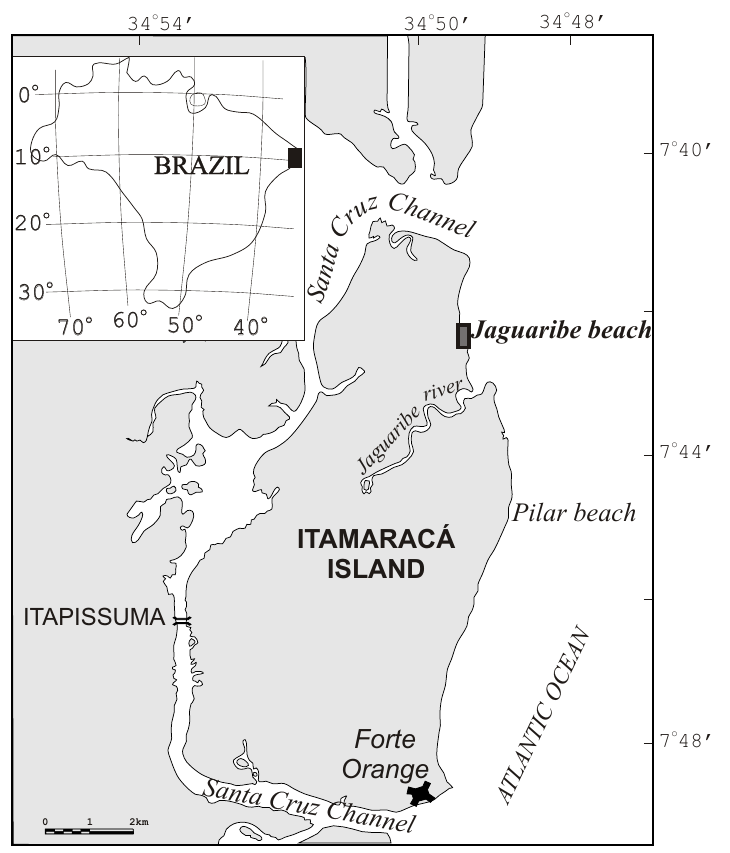
Fig. 1 – Location of the study area at the Jaguaribe beach (Itamaracá island), Pernambuco State,